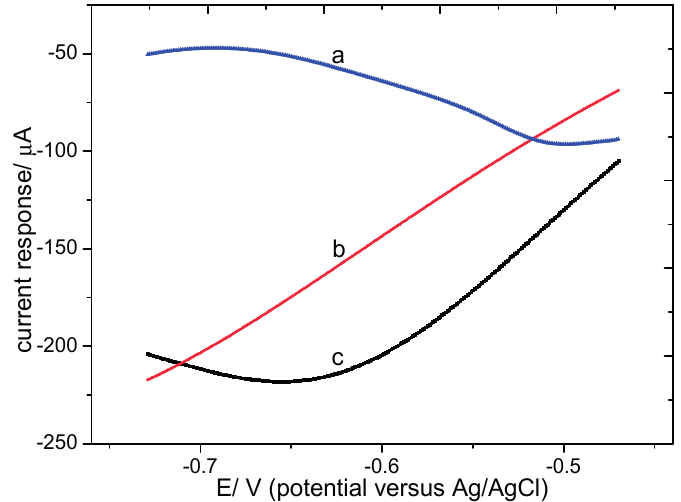
Figure 3. LSVs on ( a ) a palladium-tin modified electrode, ( b ) a bare electrode and ( c ) a palladium modified electrode in a 20 mg/L (as N) KNO 3 acidic solution.